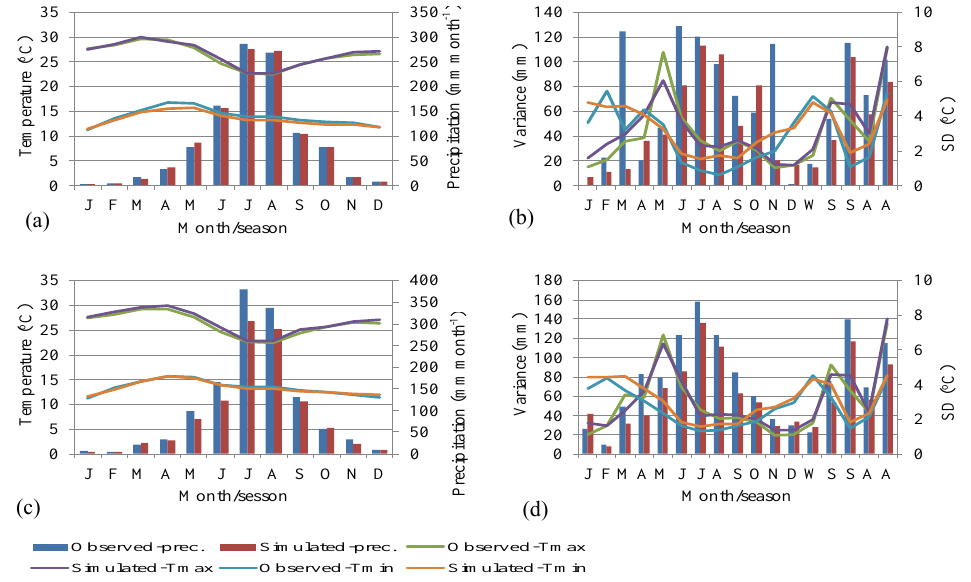
Figure 7. Validation of observed and simulated of precipitation, maximum temperature and minimum temperature for Gondar station using SDSM from canESM2 and HadCM3 from (a, b) to (c, d)